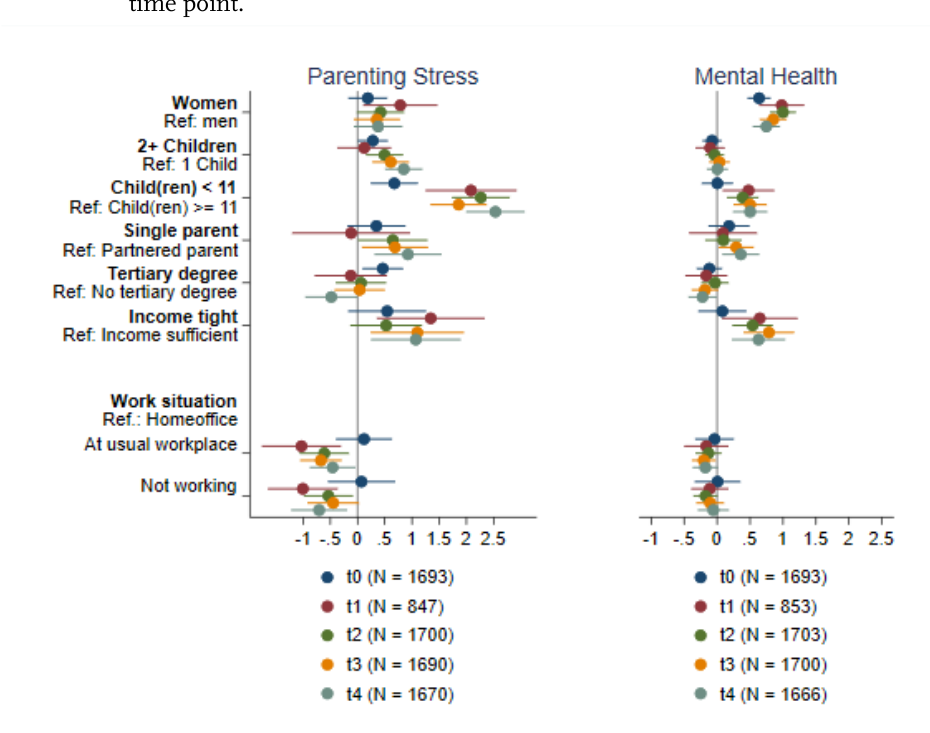
Figure 2 : Marginal effects with 95% confidence intervals of demographic and socioeconomic predictors on parenting stress and psychological distress by time